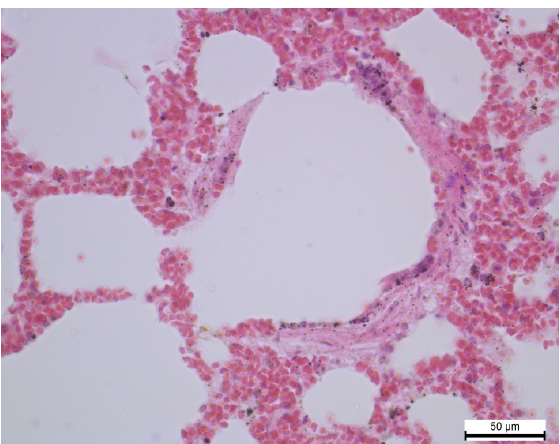
Fig. 15 A. Lungs. Bronchiectasis with a rupture of the bronchial wall. Hematoxylin and eosin. EP 10, lens 40